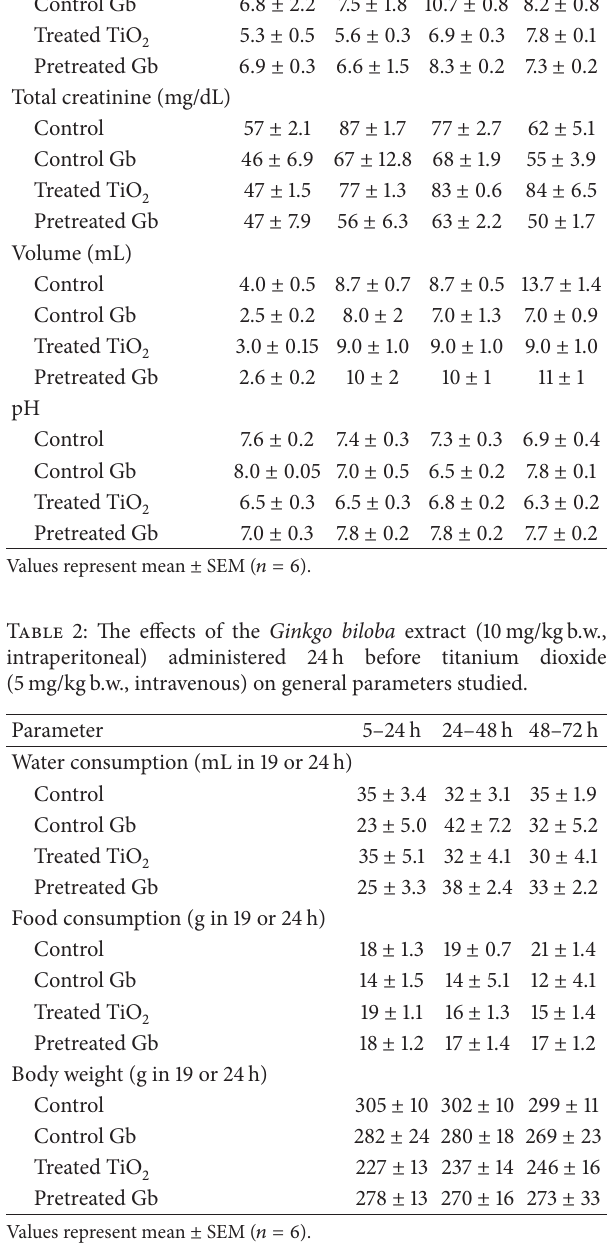
Values represent mean ± SEM ( 𝑛 = 6